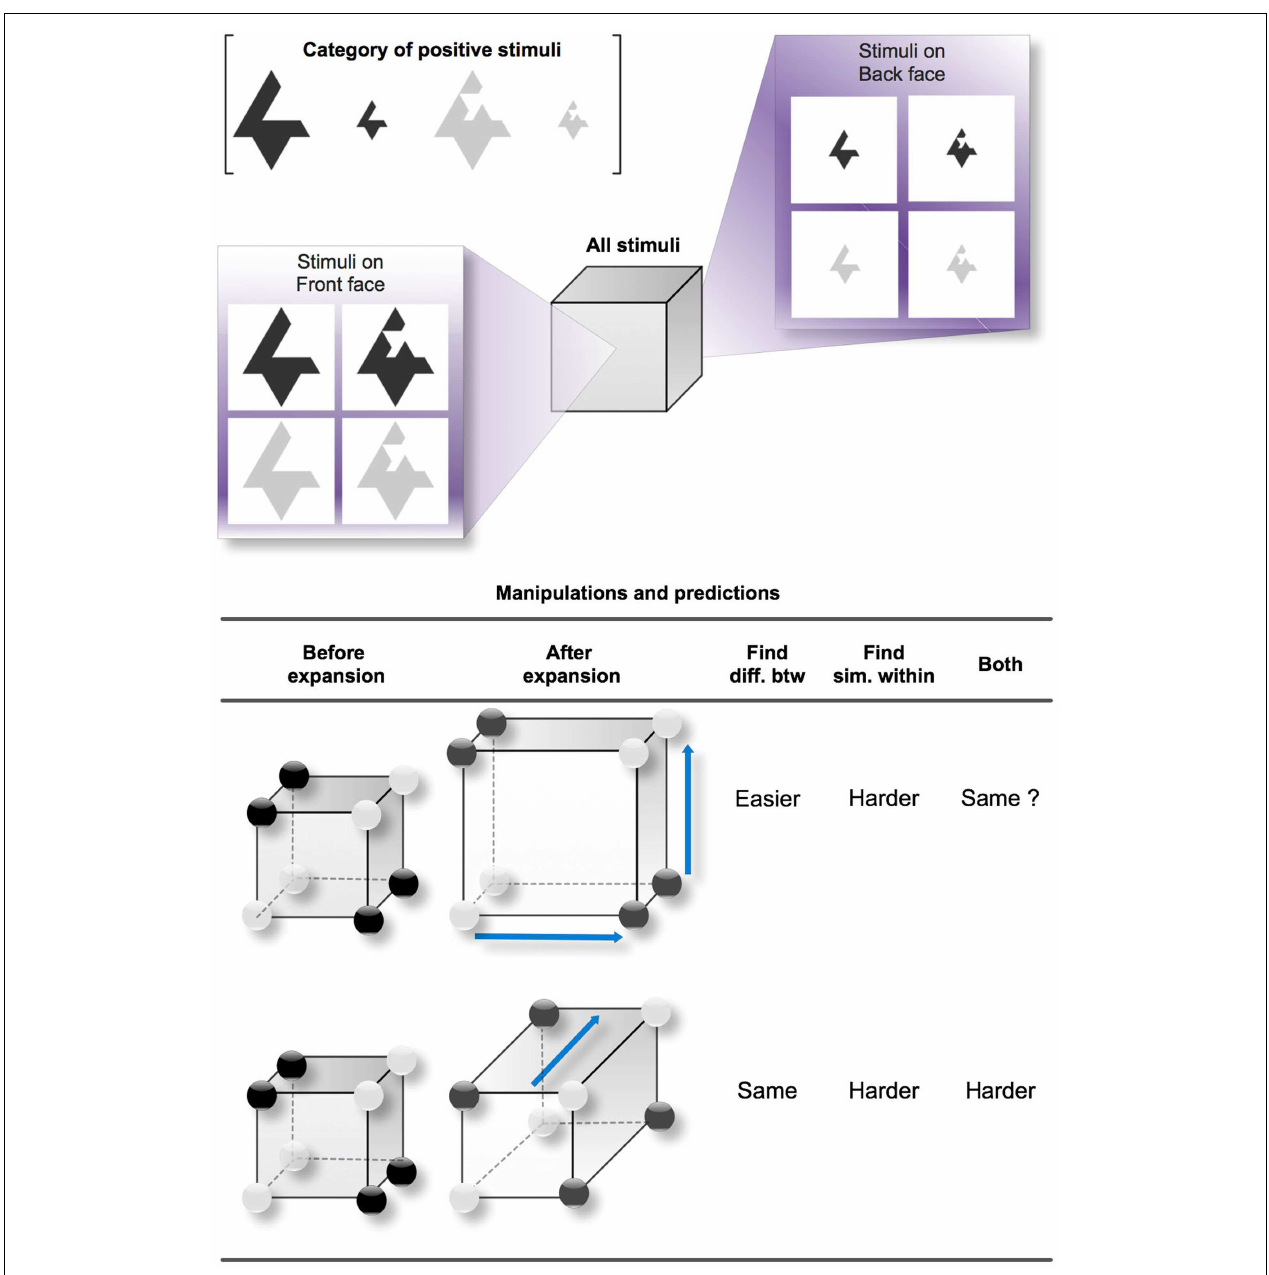
denote the positive examples of theType II concept. Here, the correct rule is ( simple and dark ) or ( complex and light ).The two study cases (one study case per line) correspond to two variations of the distances between the positive examples that we studied. In the first case, the two relevant dimensions become more salient, so the perceived distance between the clusters becomes greater. In the second case, the irrelevant dimension becomes more salient, making the distances between the objects within clusters greater.The predictions are indicated for two different processes: finding differences between categories and finding similarities between clusters (as well as both